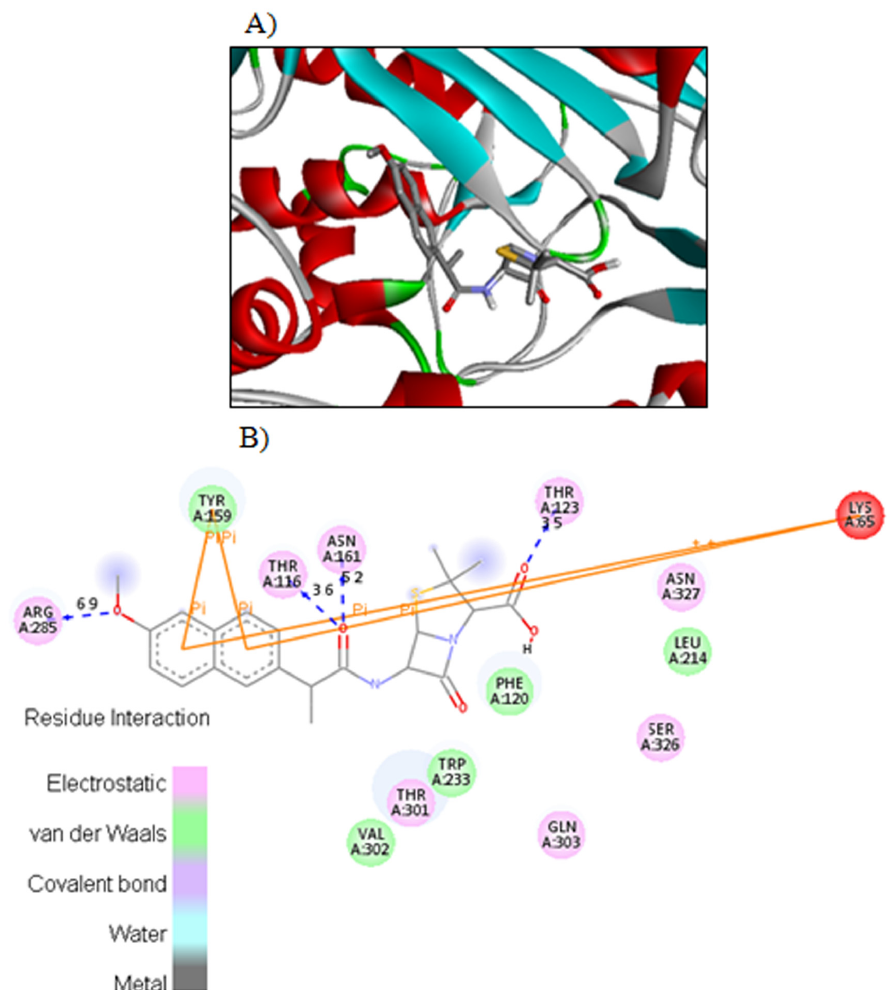
Fig 4. The potential ligand-protein interactions of compound 4e with the active site of Penicillin binding protein (PDB ID 1CEF) generated by using Discovery Studio 4.0. A) The three-dimensional docking of the compound 4e in the binding pocket. B) The two dimensional interactions of 4e with amino acid residues are shown as balls colored by the type of